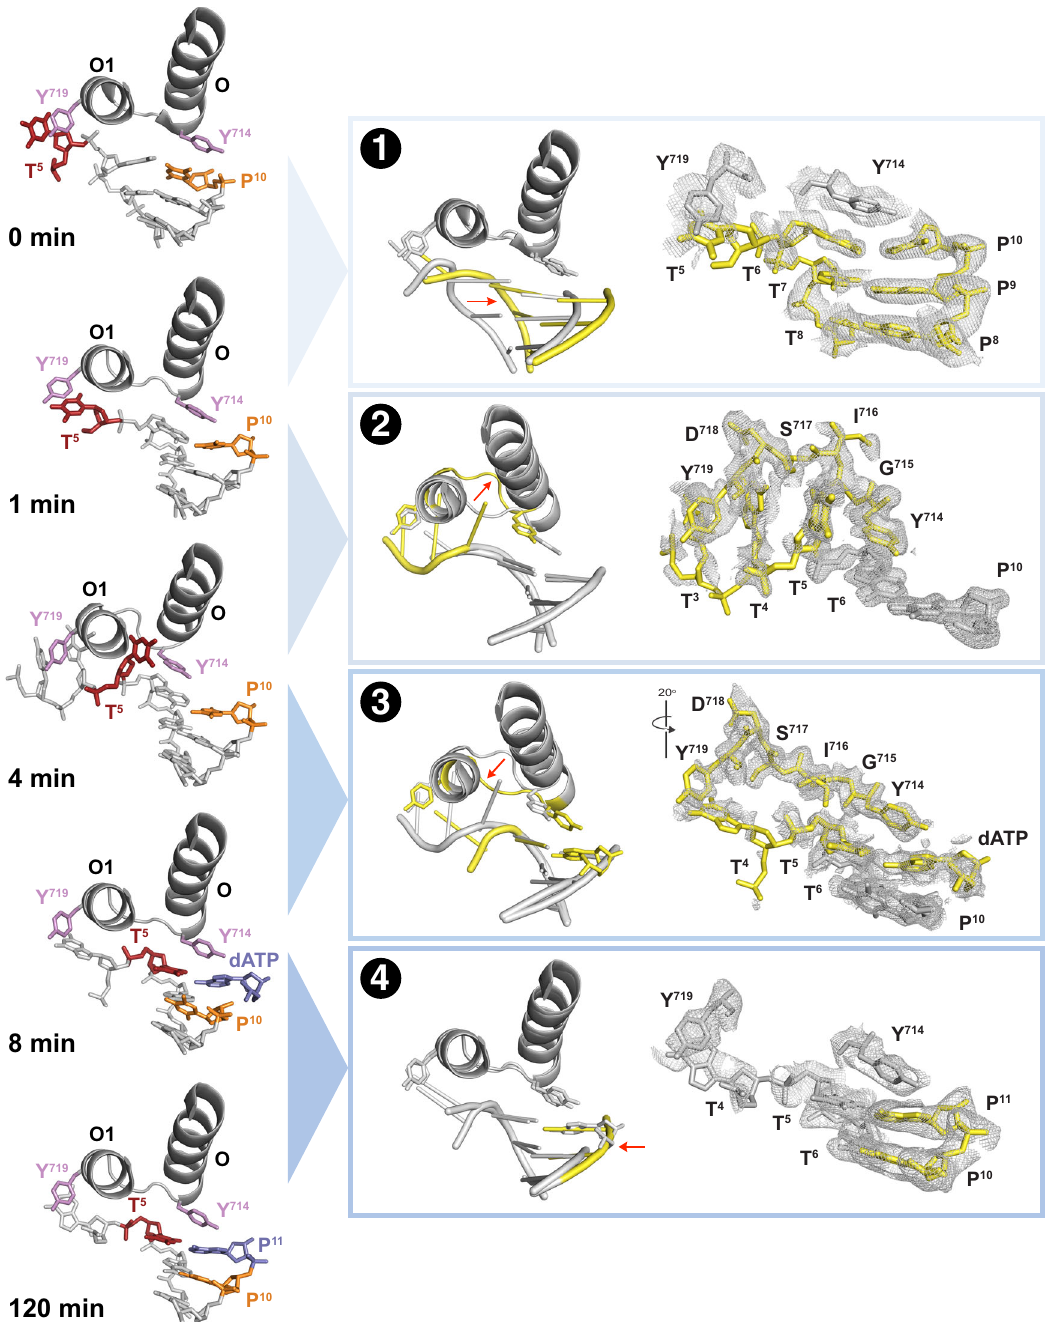
Fig. 1 Time-ordered images capture the initiation step of DNA synthesis. X-ray crystal structures of polymerase intermediates observed between 0 – 120 min (left column). Cartoon overlays and polder maps contoured at 2 – 4 σ (blue boxes). Red arrow indicates conformational changes between structures. The transitions are labeled: (1) movement of the DNA duplex, (2) opening of the O-O1 loop to form a hydrophobic pocket, (3) closing of the O-O1 loop and (4) chemical bond formation. Color scheme: 5 ’ templating base (red), Y714 and Y719 (purple), 3 ’ nucleotide of DNA primer (orange), dATP (blue), earlier reaction time (gray), and later reaction time (yellow). Abbreviations: O (O helix), O1 (O1 helix), T (template), P (primer), Y (tyrosine), D (aspartate), S (serine), I (isoleucine), and G